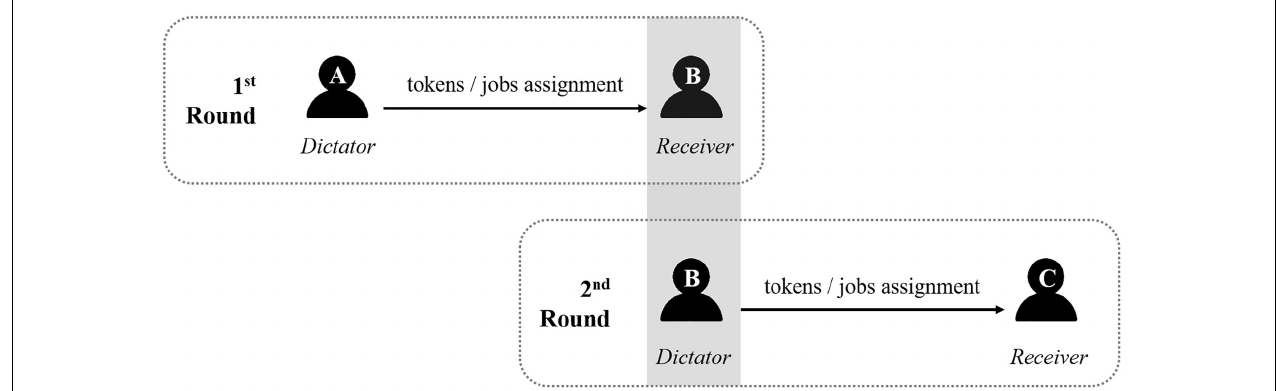
FIGURE 1 | The real role assignment of the two-round dictator game for the participant in Experiments 1 and